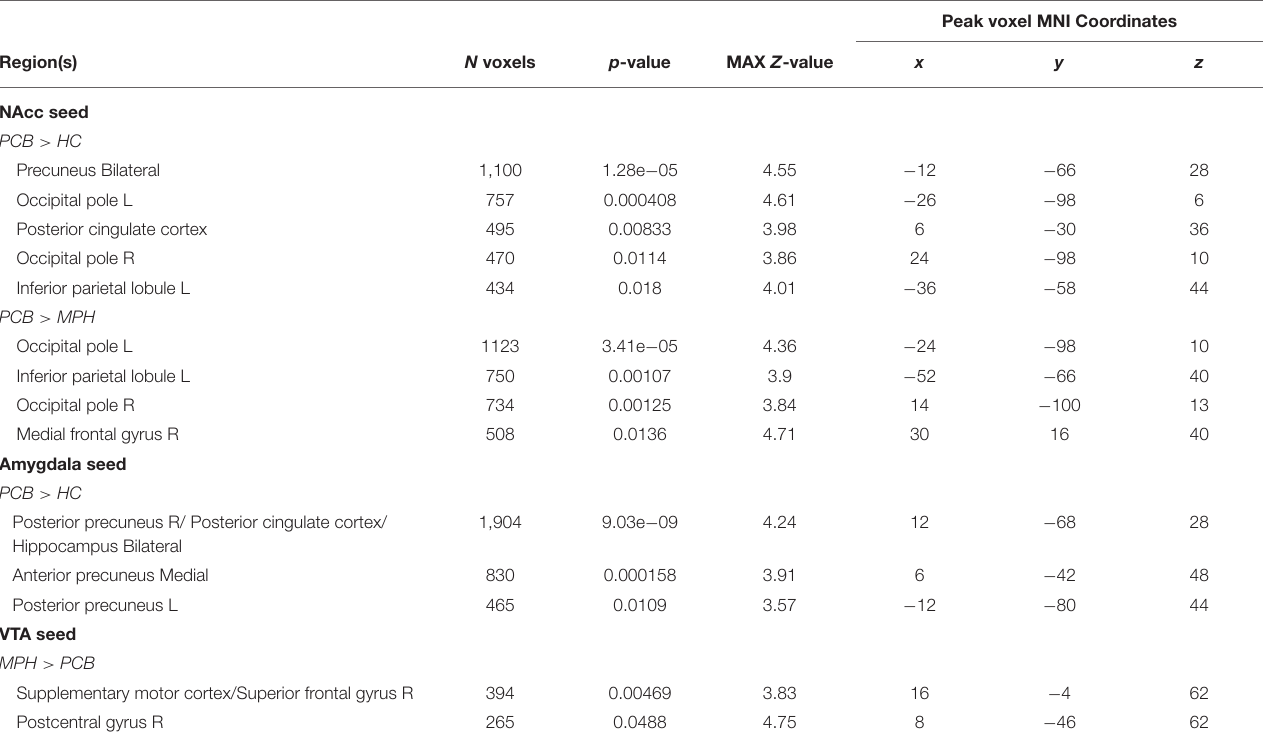
TABLE 2 | Clusters and coordinates of between group differences in